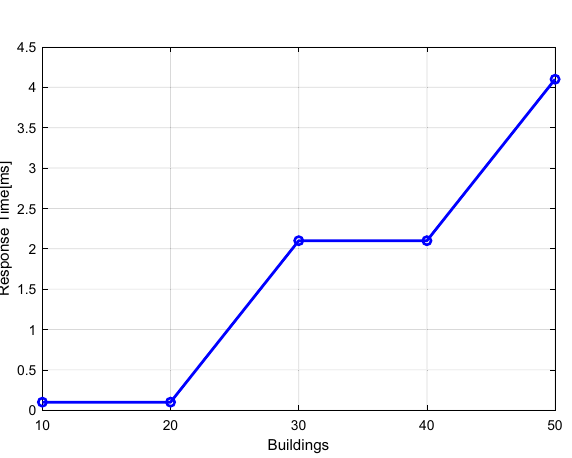
Figure 13. Memory space utilization on the fog server.